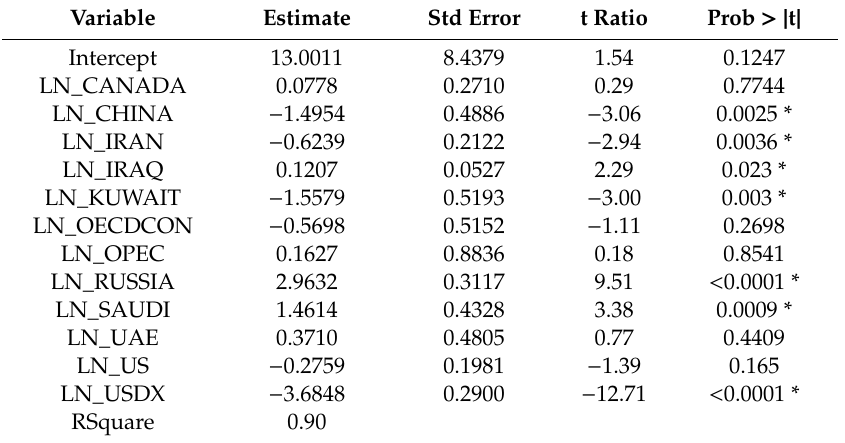
Table 2. The whole period (1998–2018): LN_BRENT prediction-parameter estimation.